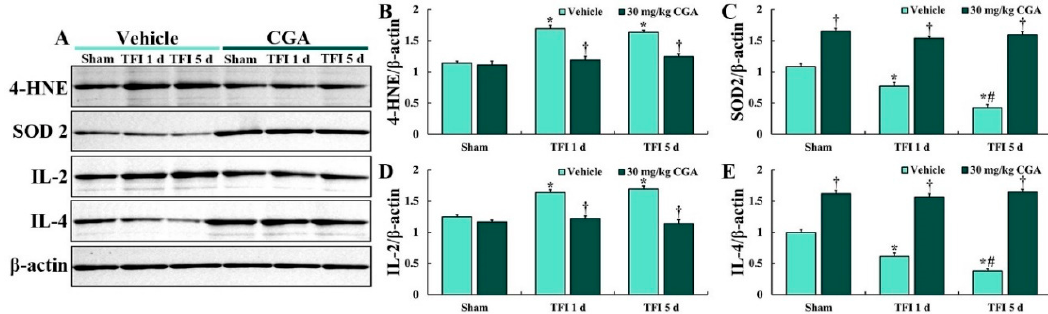
Figure 3. Representative Western blot images of 4-HNE, SOD2, IL-4 and IL-2 in the CA1 region ( A ) and densitometric analyses of them ( B – E ) in the vehicle/sham, vehicle/TFI, CGA/sham and CGA/TFI groups at 5 days after TFI. Levels of 4-HNE and IL-2 are increased in the vehicle/TFI group, but the 4-HNE and IL-2 levels in the GCA/TFI group are not altered after TFI. Levels of SOD2 and IL-2 are markedly decreased after TFI, but they are significantly higher in the CGA/sham and CGA/TFI groups than those in the vehicle/sham group days after TFI. The bars indicate the means ± SEM ( n = 5 at each point in time after TFI, * p < 0.05 vs. the vehicle/sham group, † p < 0.05 vs. the corresponding time point vehicle group, # p < 0.05 vs. the pretime point vehicle